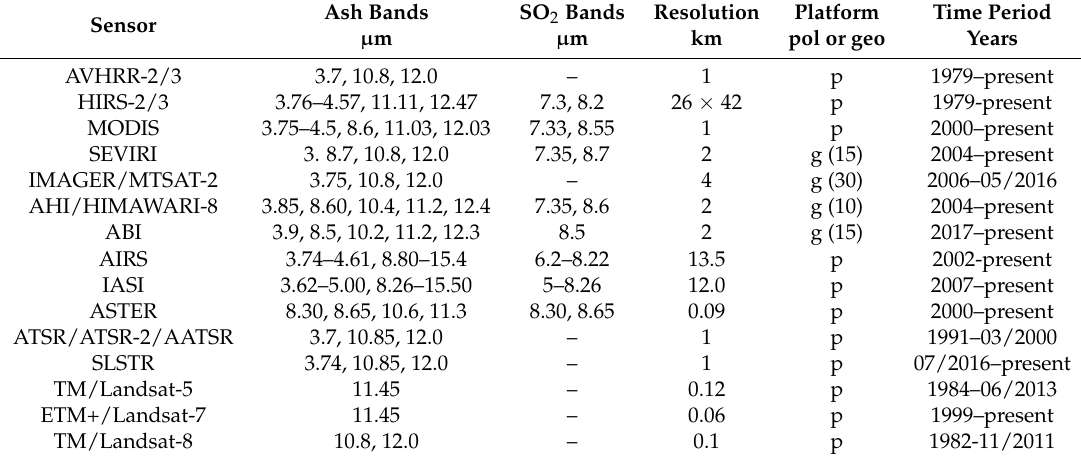
Table 2. Summary of the important aspects of polar (p) and geostationary (g) sensors used for SO 2 gas and ash measurements. Note that for some of the heritage instruments (e.g., AVHRR, along-track scanning radiometer (ATSR), ans HIRS the detailed wavelength specifications may be slightly different. The sampling time for the geostationary sensors is provided in brackets, in minutes. The period of operation is given as year of launch to month and year of decommissioning. Further details of the sensors and their platforms can be found at: